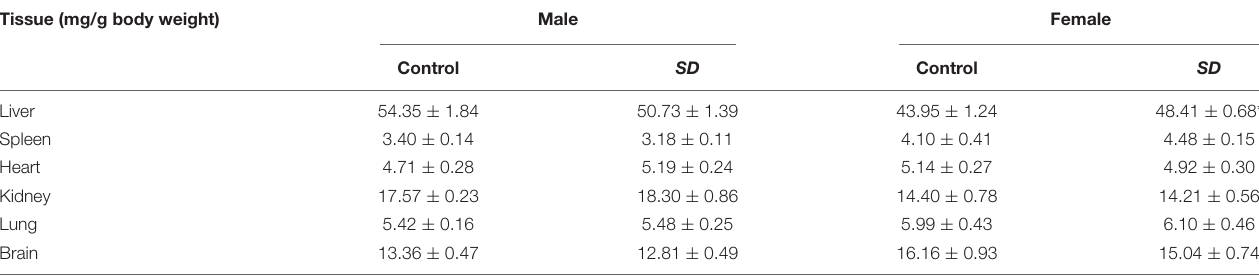
Statistical analyses were performed for a comparison between for control vs. SD for males and control vs. SD for females (mean ± SE; n = 5). *p < 0.05 (unpaired t-test).